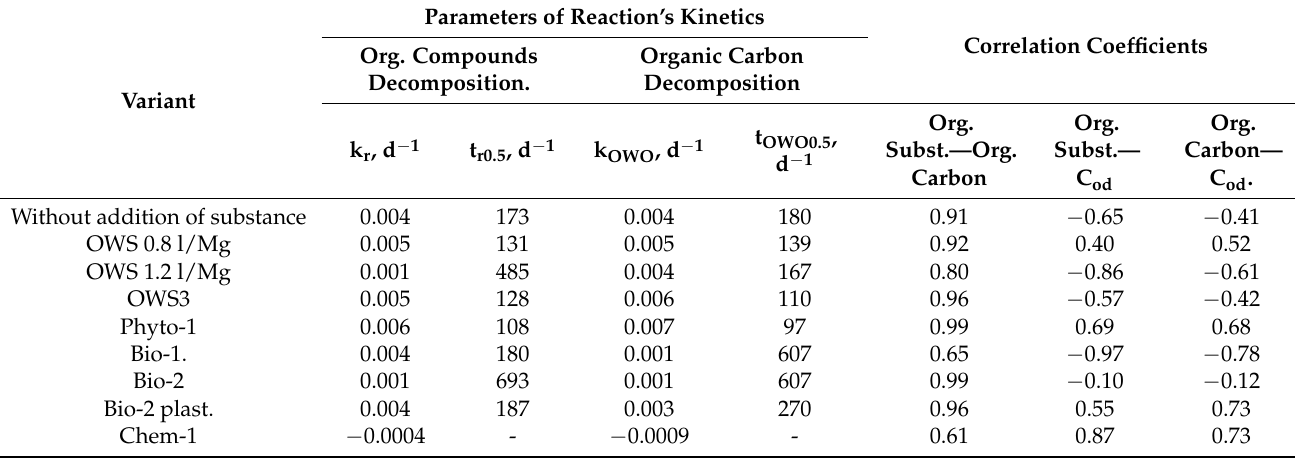
Table 3. Parameters of the kinetics of the decomposition of organic compounds and organic carbon with correlation coefficients between the concentration of organic substances, organic carbon, and odor. Parameters of Reaction’s